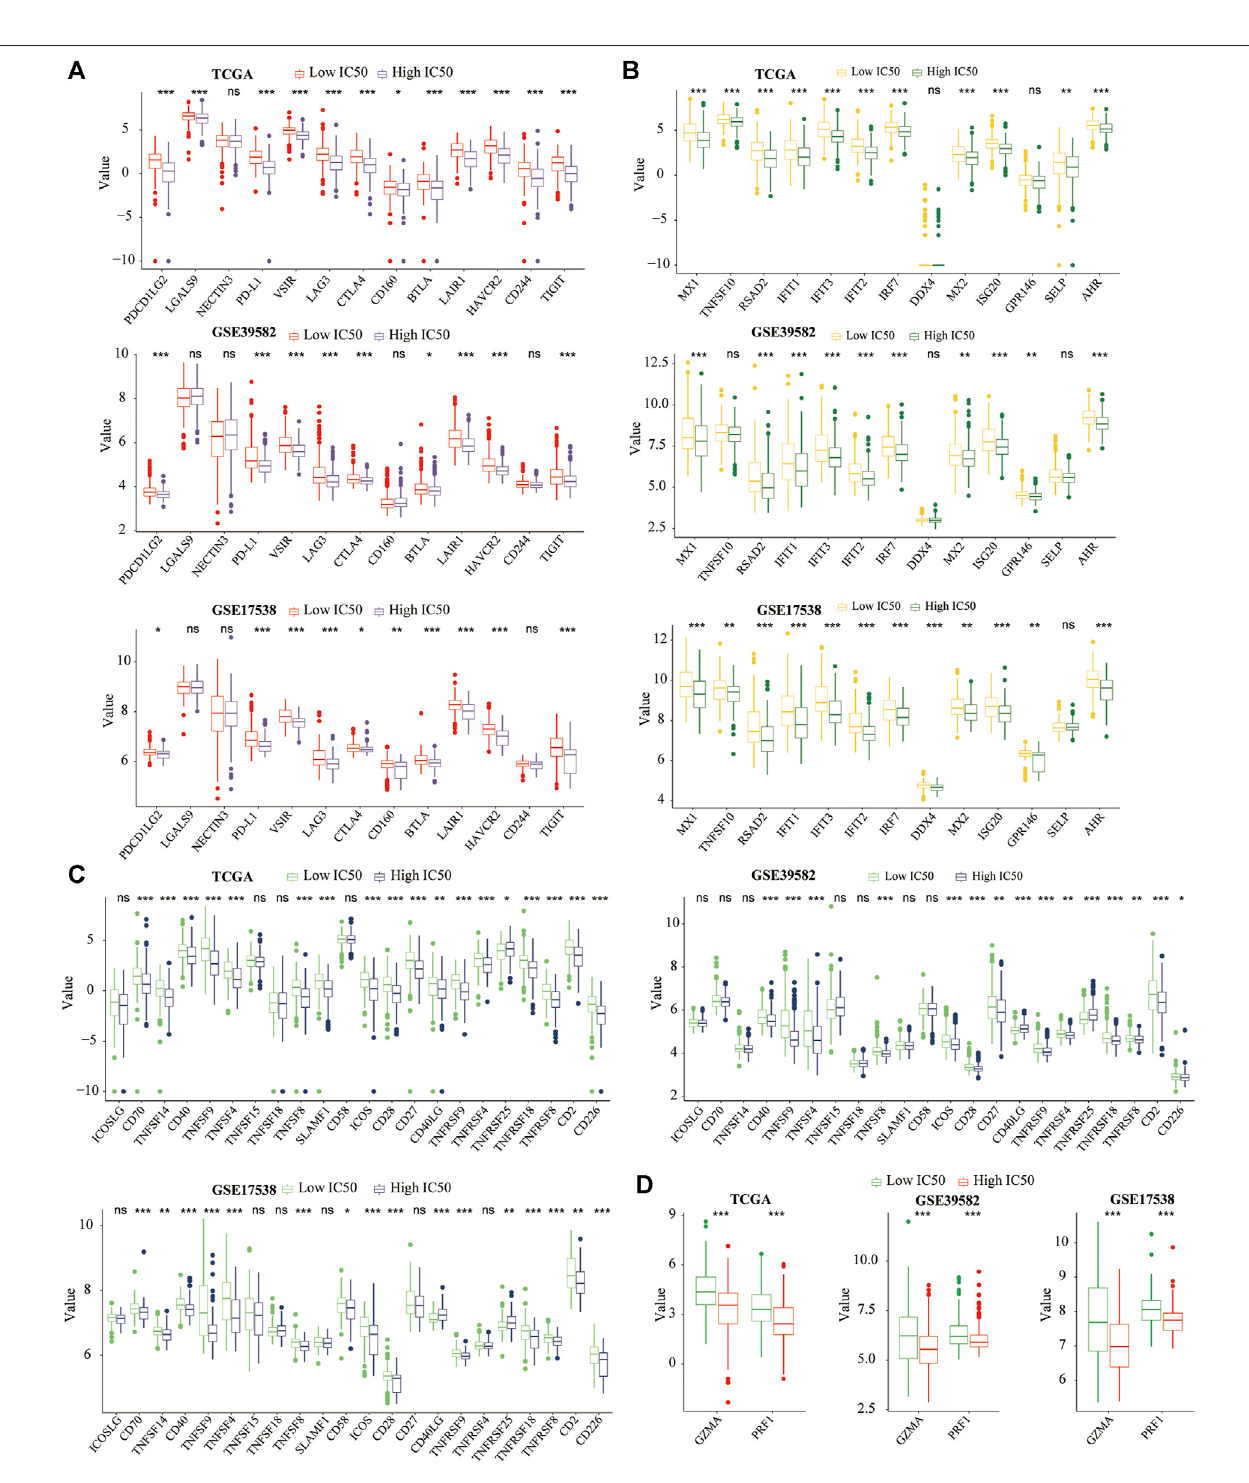
FIGURE 3 | Differences of immune-related genes. The most (A) co-inhibitory molecules, (B) IFN response molecules, (C) co-stimulatory molecules, (D) cytolytic activity molecules were signi fi cantly higher in the low-IC50 group. * p < .05, ** p < .01, *** p < .001.